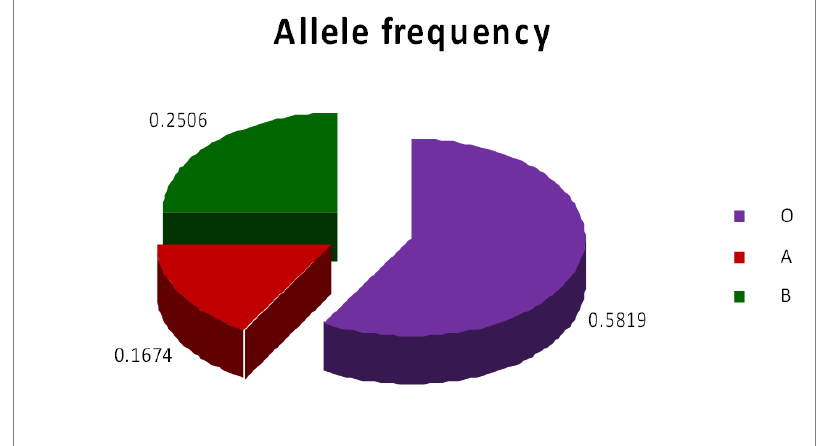
Fig. 2. Allelic frequencies of A, B, and O blood groups in total 1065 samples